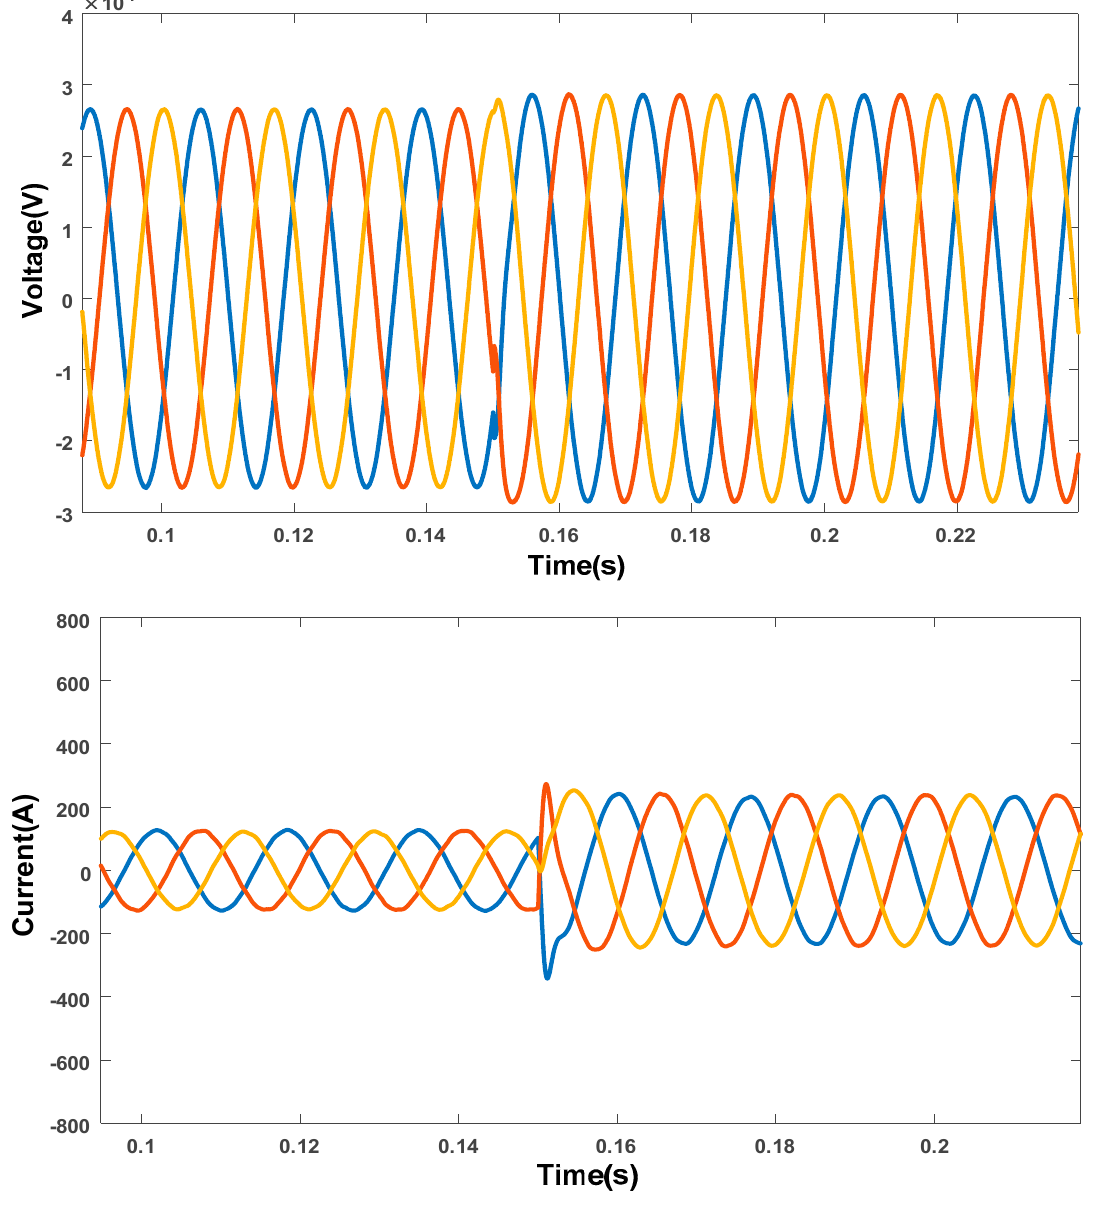
Figure 17. The grid side voltage and current.